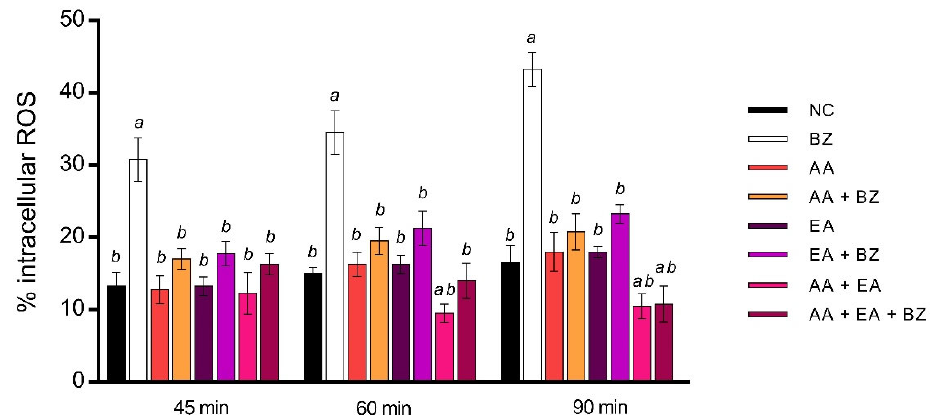
Figure 2. Percentage of intracellular reactive oxygen species (ROS) observed in human sperm cells (n-values: 34) after 45, 60 and 90 exposure min to 0.4 µ L/mL benzene (BZ), 100 µ M ascorbic acid (AA), 100 µ M ellagic acid (EA), and their combination. NC stands for negative control. Letters correspond to diverse statistical significances (ANOVA); a: p < 0.05 in comparison with NC; b: p < 0.05 in comparison with BZ exposure.